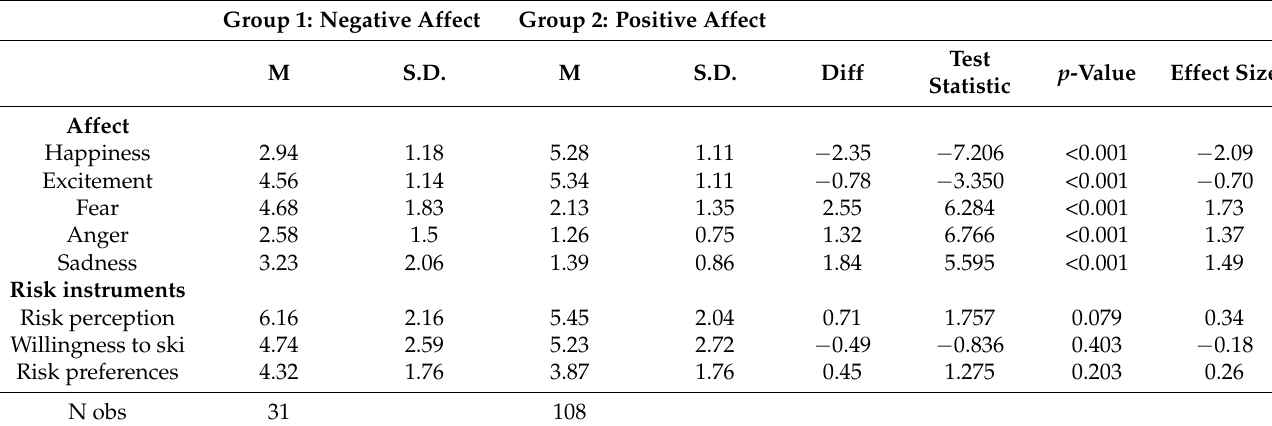
Table 4. Mean responses and bivariate tests of differences between negative and positive affect. Mann–Whitney U